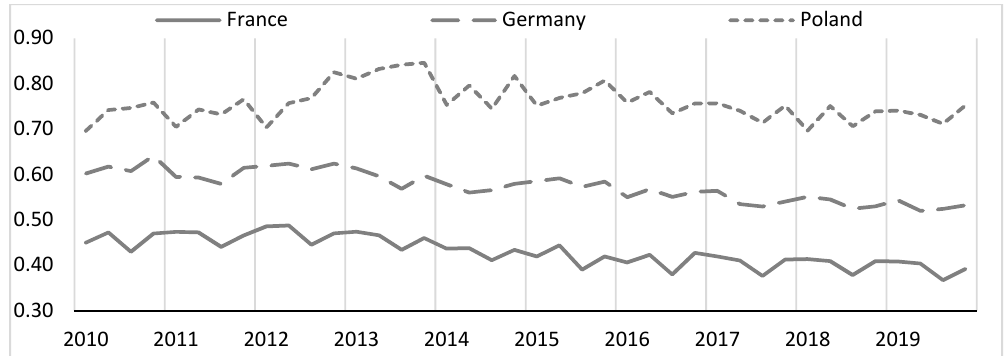
9 of 17 Figure 4. Import intensity of private consumption, own work, source: Eurostat.